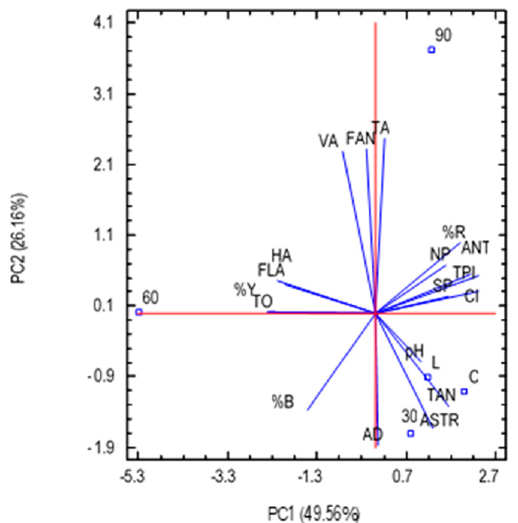
Figure 1. Principal component analysis of wines and oenological parameters. Symbols. C: Control; L: Ultrasound-untreated lees; 30, 60, 90: ultrasound-treated at an amplitude level of 30%, 60%, and 90%, respectively. Code of oenological parameters (see Table